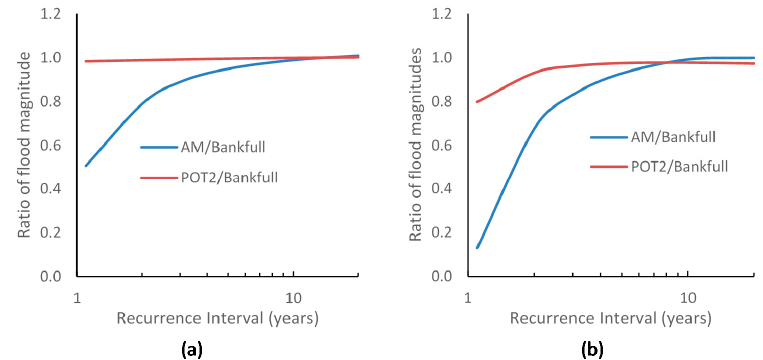
Figure 9. Comparison of recurrence interval and flood magnitude between the AM, partial and BF series for ( a ) a wet-tropical river (Site ID 114); and ( b ) a dry-tropical river (Site ID 119).